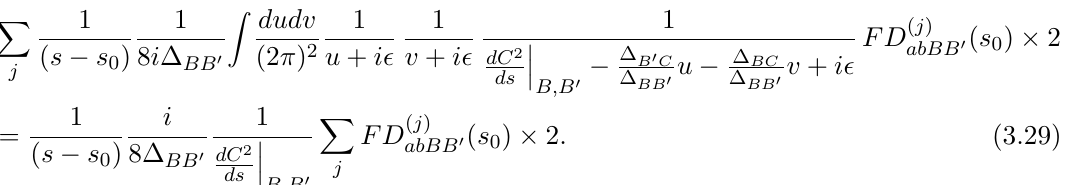
Figure 7 . Sum over diagrams contributing to the pole at order ( s − s 0 ) − 1 and containing on-shell momenta B , B 0 and C (on the left-hand side). The blob FD ( j ) is any finite tree-level graph having for external states B , B 0 p and p . Since in a tree-level non-allowed 4 -point process the sum a b over all the finite Feynman diagrams plus the pair of singular ones, in which on-shell bound states propagate, is zero, the sum over the FD ( j ) s yields the two singular diagrams in square brackets on the right-hand